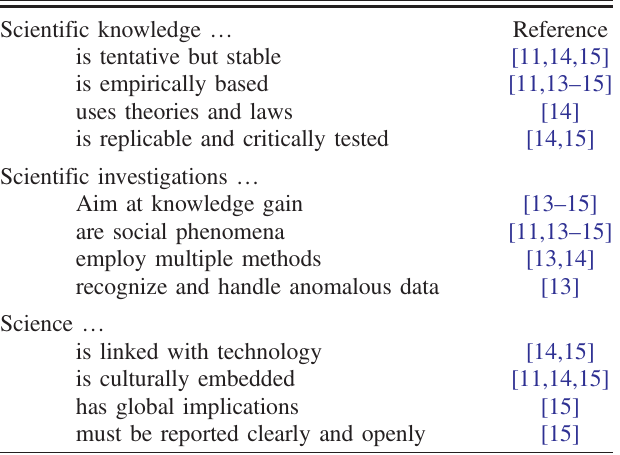
TABLE I. Aspect of NOS based on the juxtaposition by Neumann and Kremer [18], employing the works by McComas and Olson [15], Osborne et al. [14], Lederman [11] (p. 304), and Schwartz et al. [13] (p.